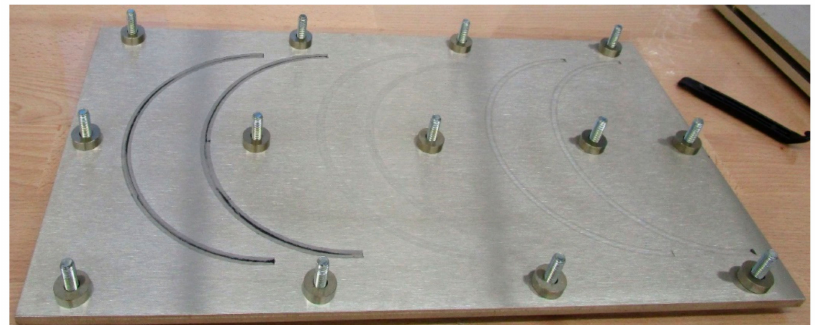
Figure 14. Flange on which two half O-rings made of EPDM (left), FKM (fluorocarbon rubber, middle) and HNBR (right) had aged in the compressed state for 182 d at 125 ◦ C.